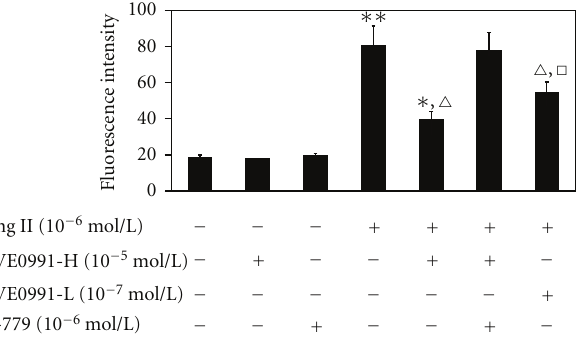
Figure 4: The e ff ect of AVE0991 on Ang II-stimulated ROS production in VSMCs. ∗ P < 0 . 05; ∗∗ P < 0 . 01 versus control group; (cid:5) P < 0 . 01 versus Ang II group; (cid:2) P < 0 . 05 versus Ang II + AVE0991- H group; n = 8.